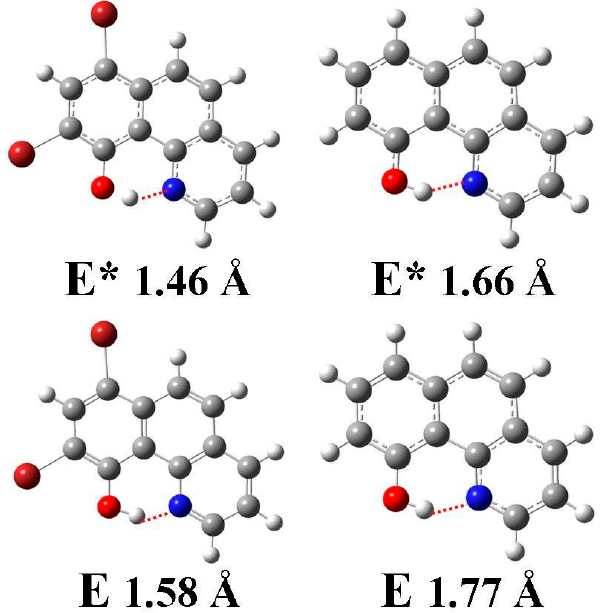
Figure 4. The optimized geometric structures of the enol (E) form for 1 (left) and 2 (right) in the ground (S 0 ) and the first singlet excited state (S 1 ) together with the intramolecular hydrogen bond lengths. The red dashed lines denote the intromolecular O–H ⋅⋅⋅ N hydrogen bonds.